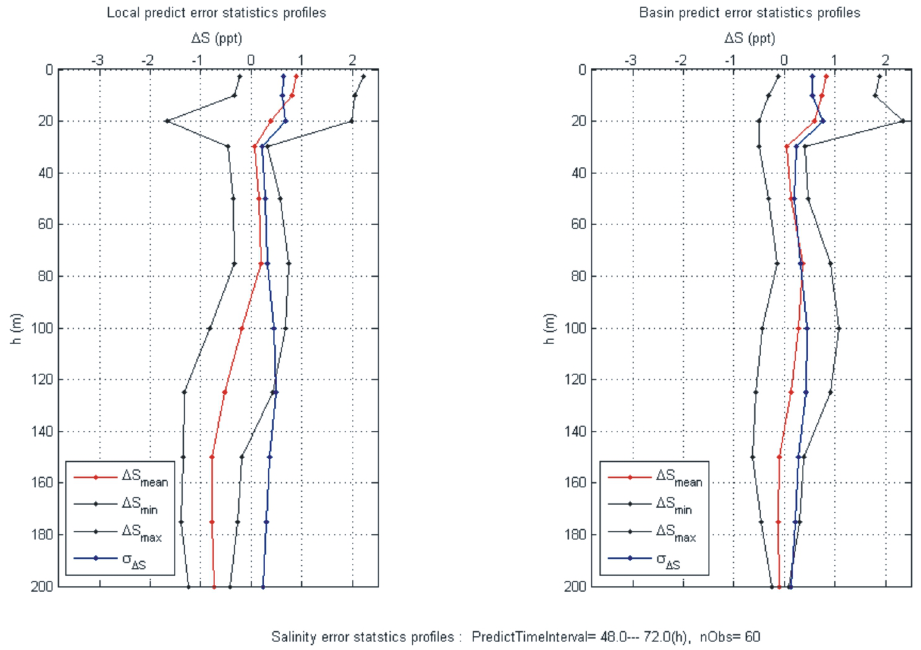
Fig. 13. Bias (red) and standard deviation (blue) of simulations and observations for the local model (left) and the basin-scale one (right) for the survey near the Crimea. Extreme deviations for every level are shown by black lines on the both